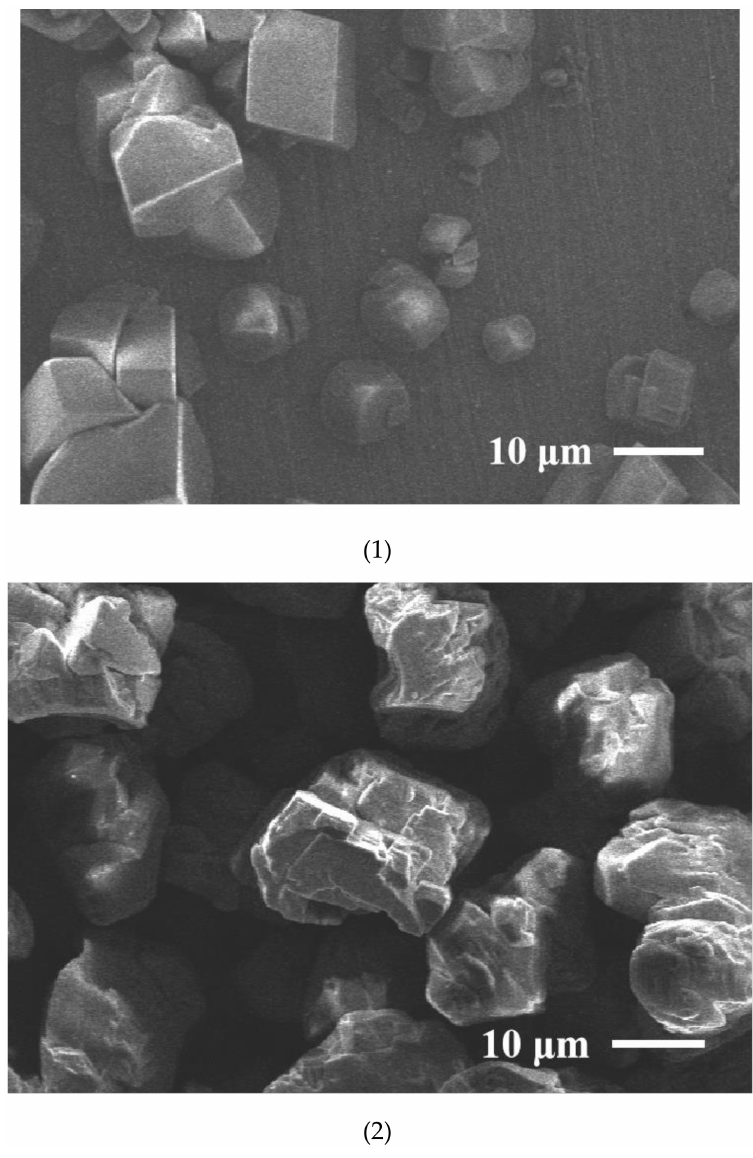
Figure 6. The morphology of CaCO 3 crystals on the cathode surface in the scaling solution containing 8 mg / L PBTCA, under di ff erent polarization potentials. ( 1 ) Polarization at − 1.0 V; ( 2 ) Polarization at − 1.5